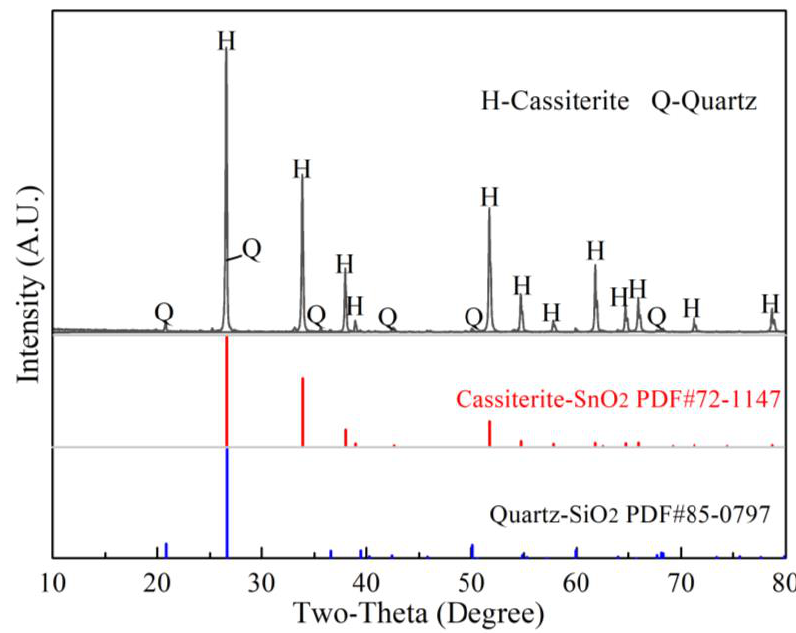
Figure 1. XRD patterns of Si-bearing cassiterite concentrates.